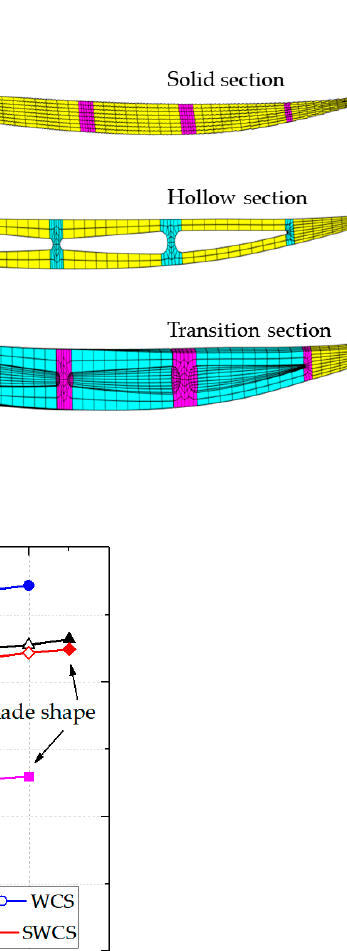
Table 3. Structural parameters of hollow fan blade.